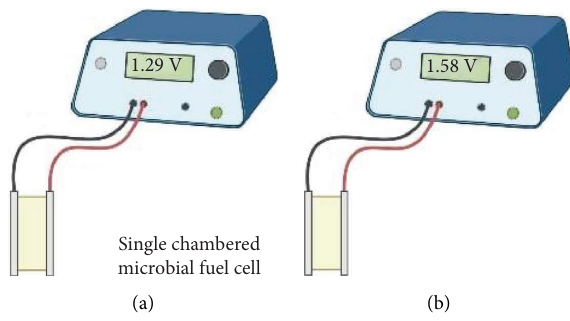
Single chambered microbial fuel Figure 2: Maximum voltage from SCMFC (a) without fabricated cathode and (b) with fabricated